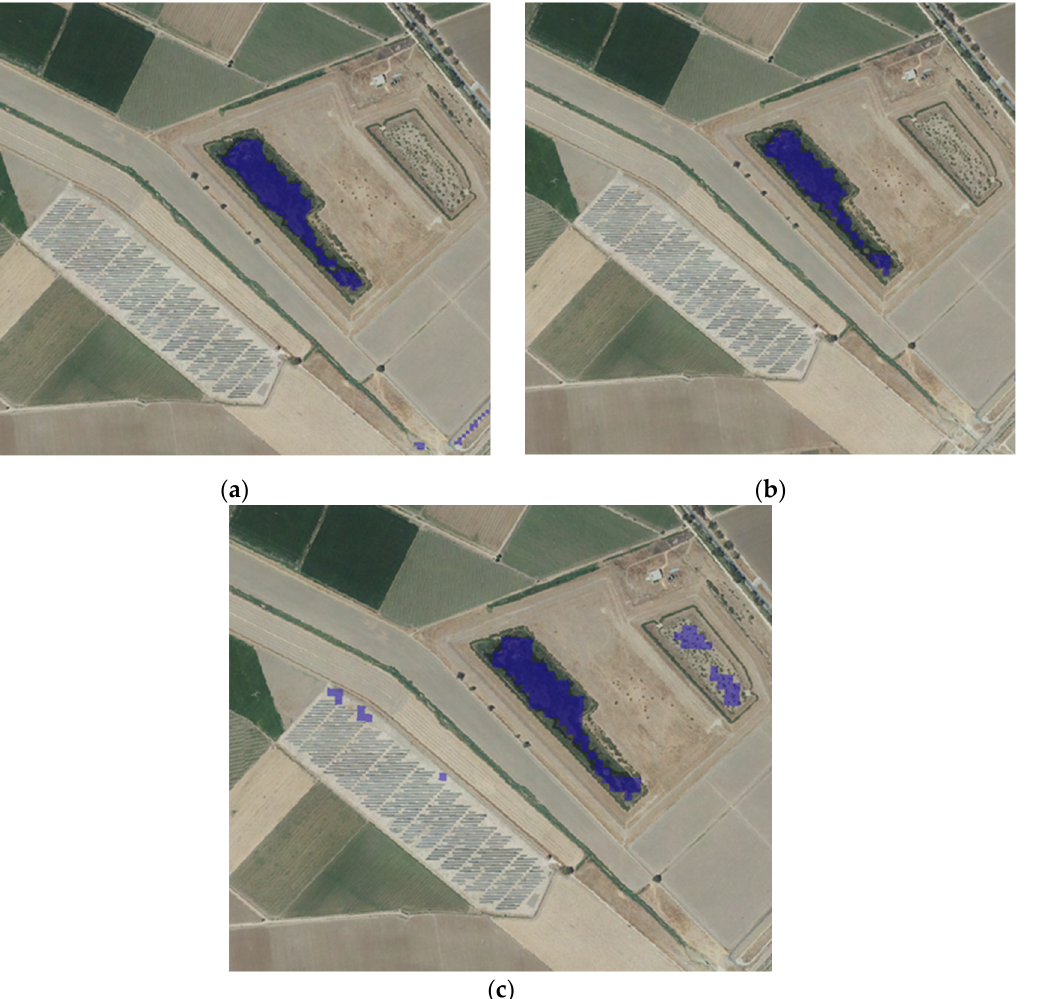
Figure 14. Bodies of water detected in the vicinity of plant 4 for a specific instant of time based on: ( a ) the NDWI with a 10-m spatial resolution, ( b ) the NDWI with a 20-m spatial resolution, and ( c ) the SWI with a 20-m spatial resolution.